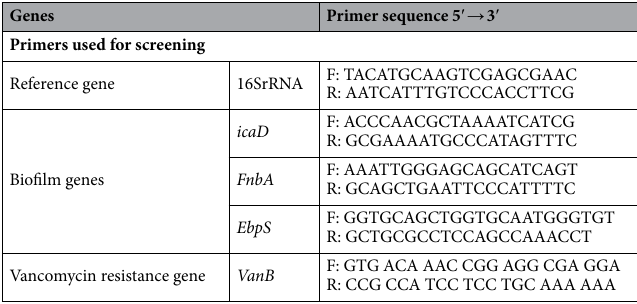
Table 2. Sequence of primers used in this